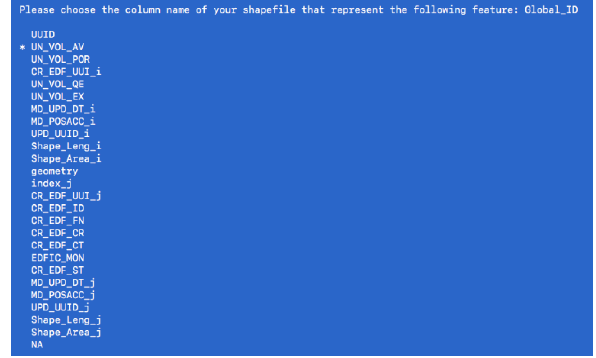
Figure 3. Multiple selection: the user is asked to indicate which feature of the input shapefile meets a specific